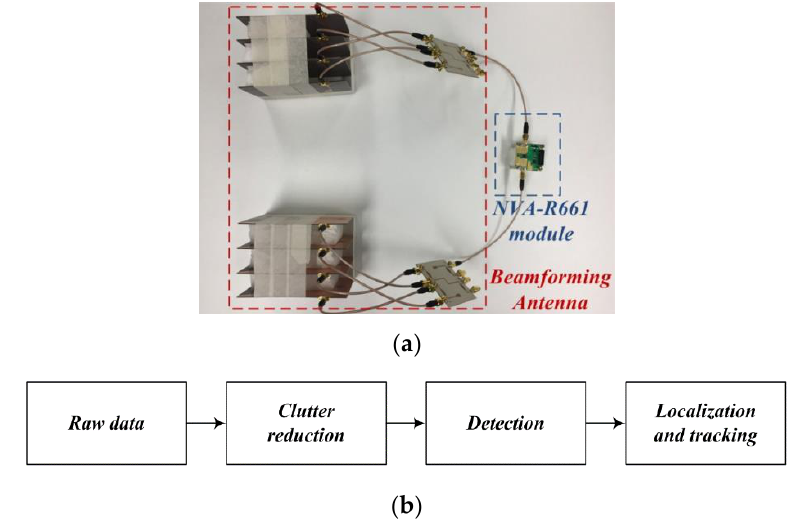
Figure 28. Configuration of the proposed radar system: ( a ) radar connected to beamforming antenna and NVA-R661 module and ( b ) signal